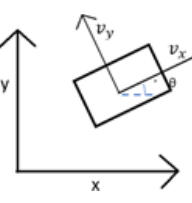
Figure 7. Mobile platform